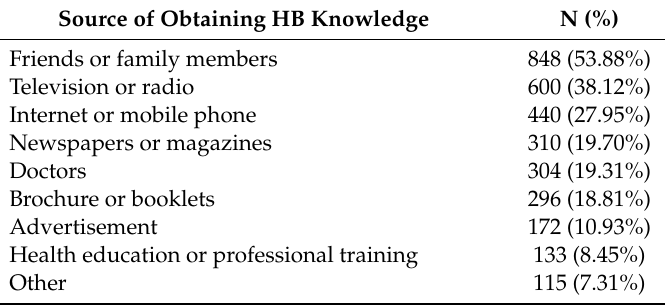
Table 4. Access to hepatitis B (HB) knowledge (N =